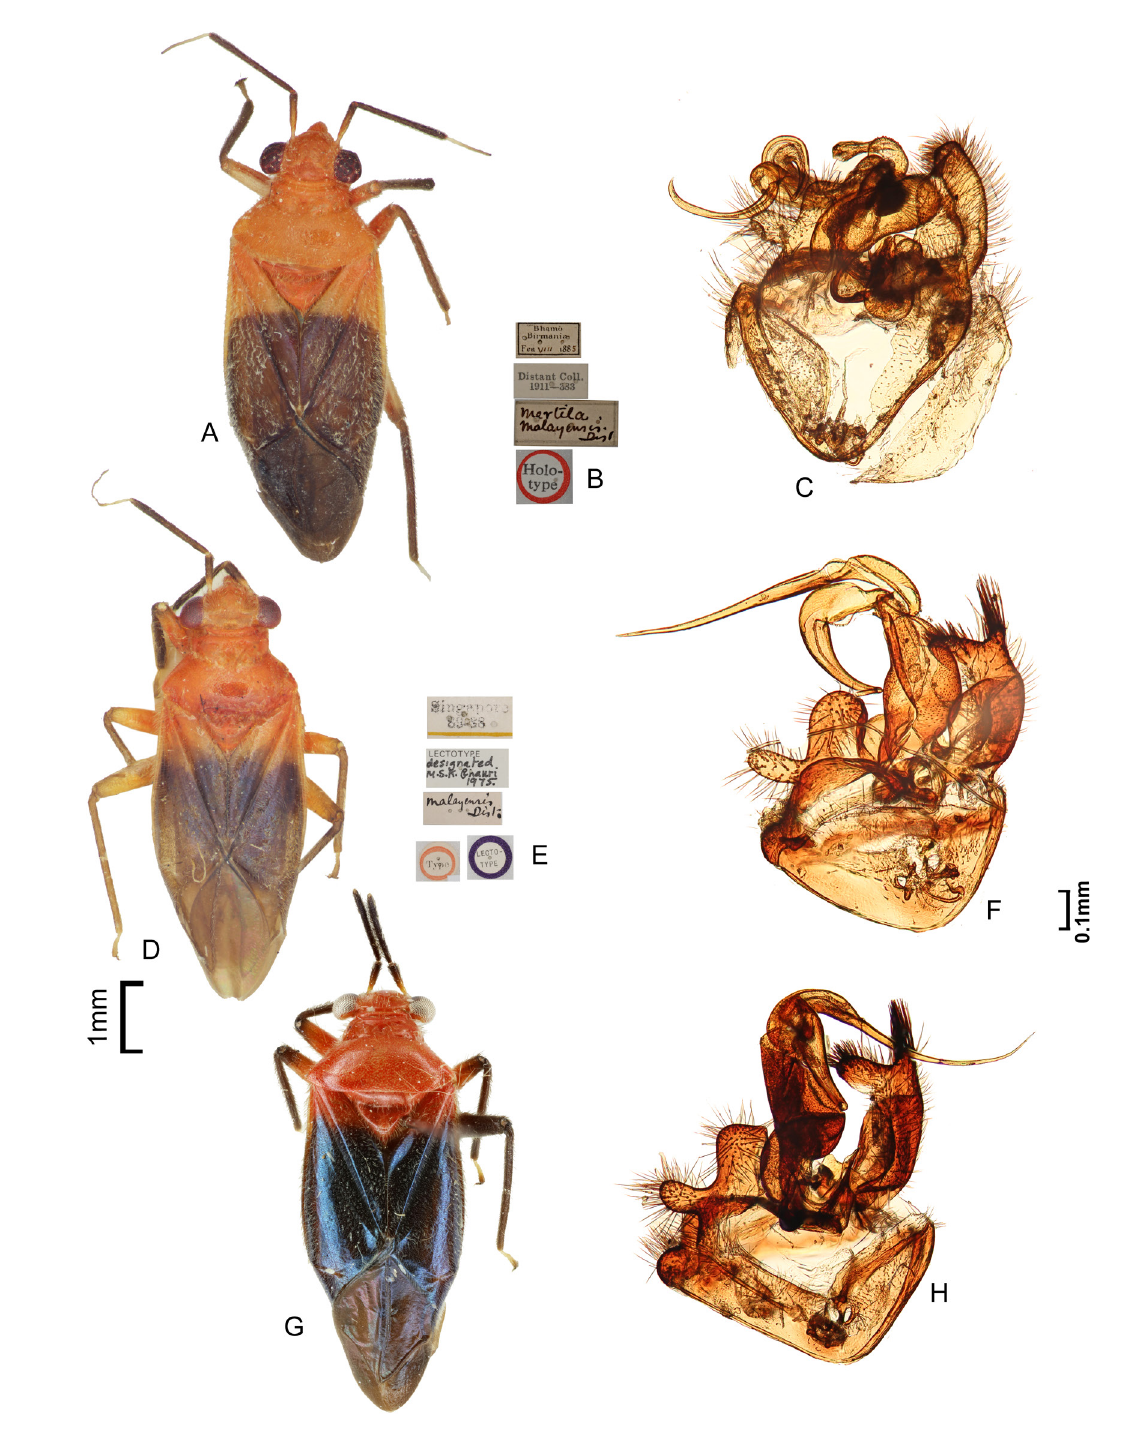
Fig. 8. Dorsal view, male genitalia and label data of type specimens for Mertila spp. A–C .